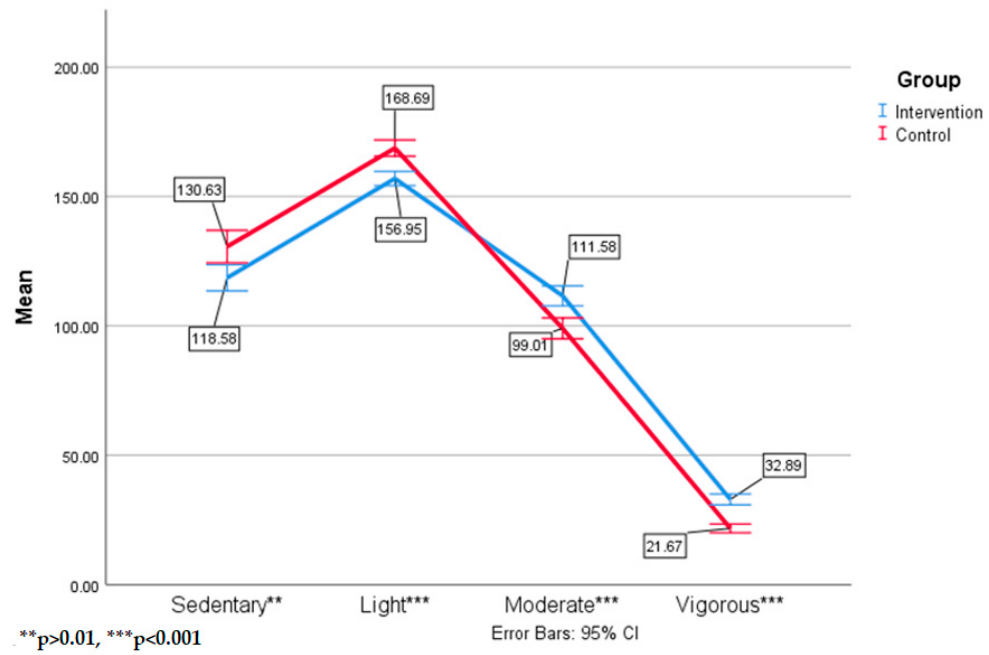
Figure 2. Means and standard deviations of time by physical activity (PA) intensities by group.